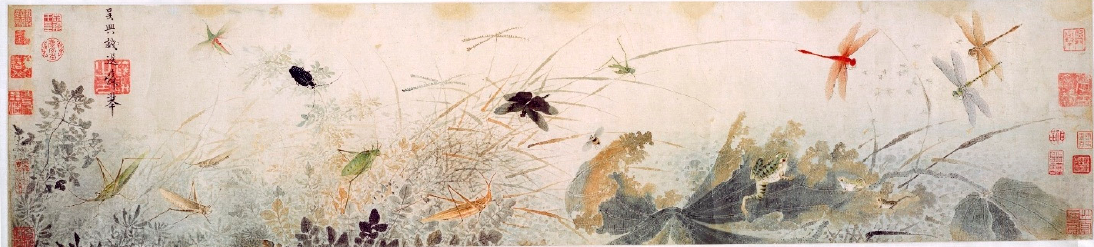
Figure 1. Early Autumn, painting by Qian Xuan (China, 1235–1305, Yuan Dynasty; [69]. Reproduced from https://en.wikipedia.org/wiki/Qian_Xuan, visited on 2 November 2018).